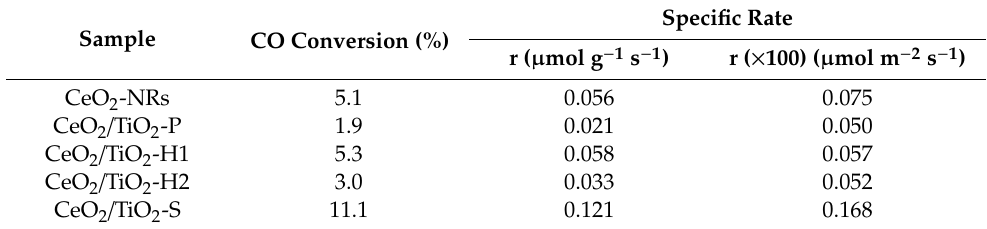
Table 2. Conversion of CO and specific rates of CeO 2 and CeO 2 / TiO 2 samples at 200 ◦ C. Reaction conditions: 0.2 vol.% CO and 1 vol.% O 2 in He.